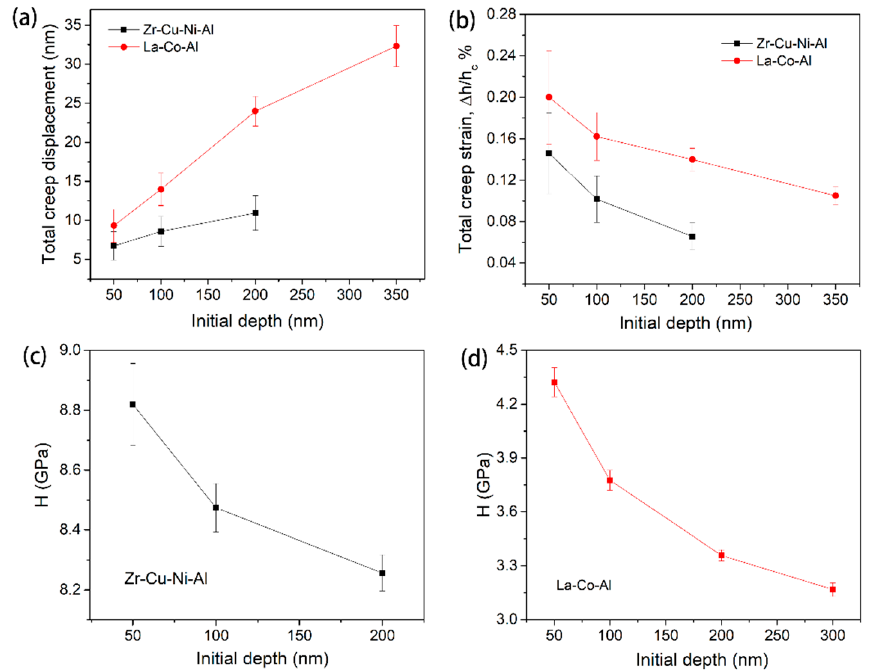
Figure 5. ( a ) The total creep displacement and ( b ) creep strain for at various initial holding depths for both samples; ( c ) hardness at the onset of the holding stage as a function of initial holding depth for ( c ) Zr-Cu-Ni-Al and ( d ) La-Co-Al.